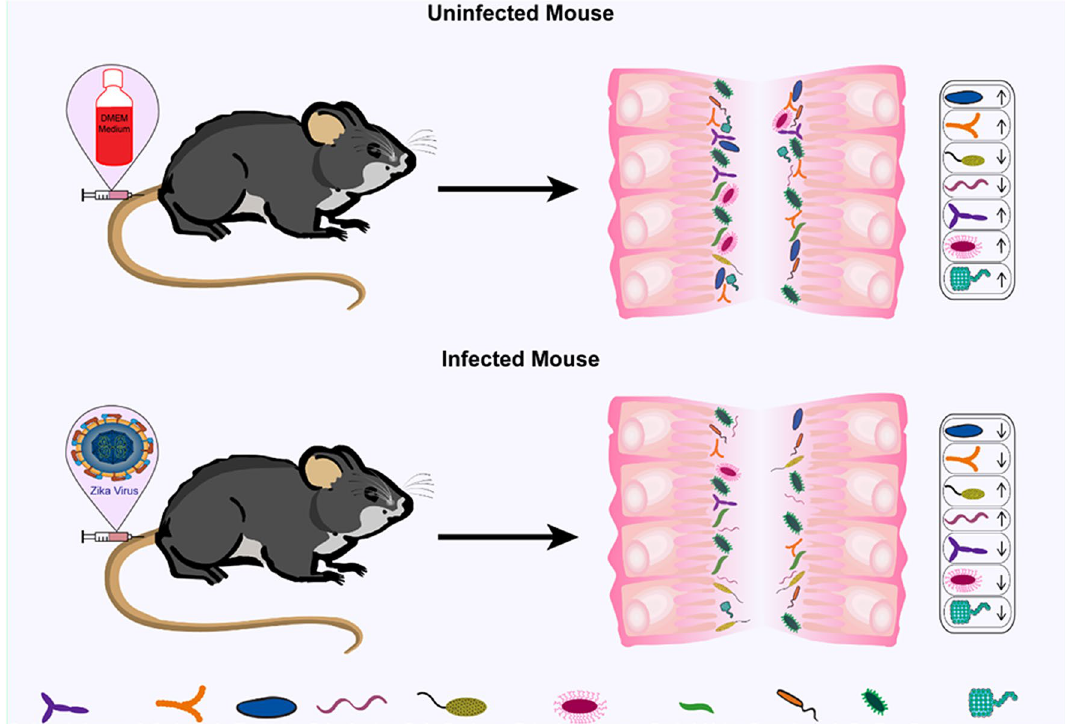
Figure 5. ZIKV infection modulates composition and abundance of specific bacterial taxa from the gut microbiota of the adult immunocompetent mice. ZIKV infected mice (bottom) show significantly altered intestinal microbiota compared to uninfected mice (top). The phyla Proteobacteria, Bacterioidetes, and Bacillus displayed no significant difference between uninfected mice and those infected with ZIKV. ZIKV infection significantly (p < 0.01) decreased the abundance of Firmicutes and Actinobacteria phyla and increased Deferribacteres and Spirochaetes phyla in the gut microbiota of C57BL/6J mice compared to uninfected